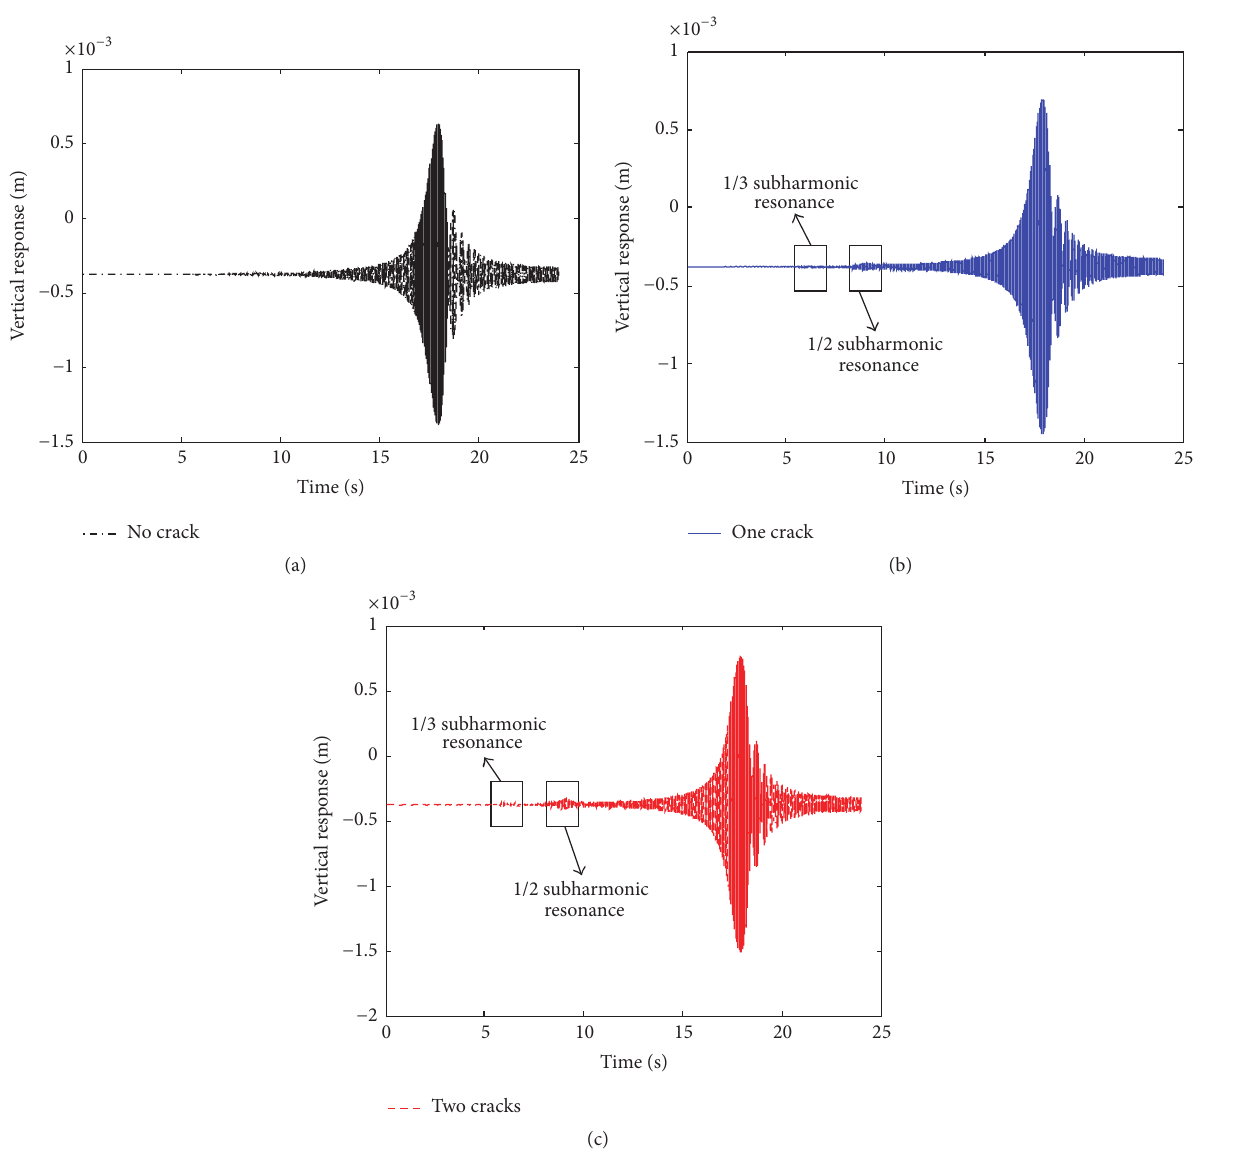
Figure 4: Run-up responses comparison of rotors without any crack, with one crack and with two cracks. (a) No crack. (b) One crack located in the 12th element with depth of 0.2. (c) Two cracks located in the 11th and 17th elements both with depth of 0.2.